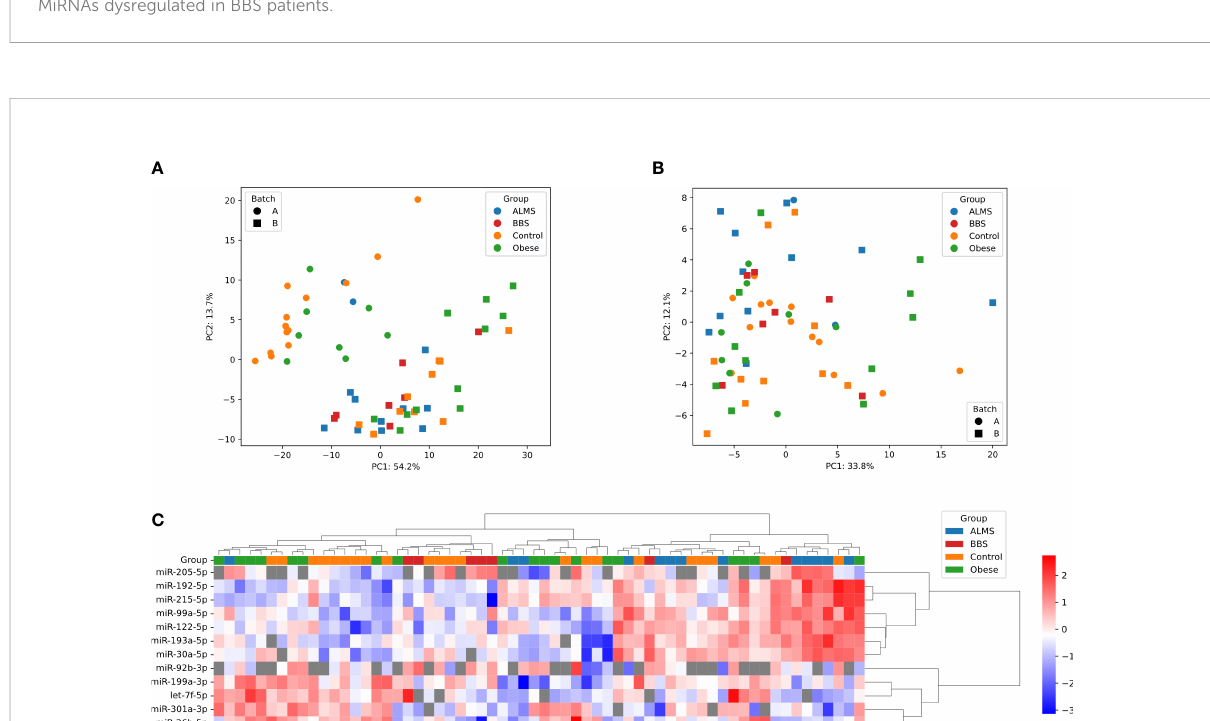
FIGURE 3 MiRNAs dysregulated in BBS patients.